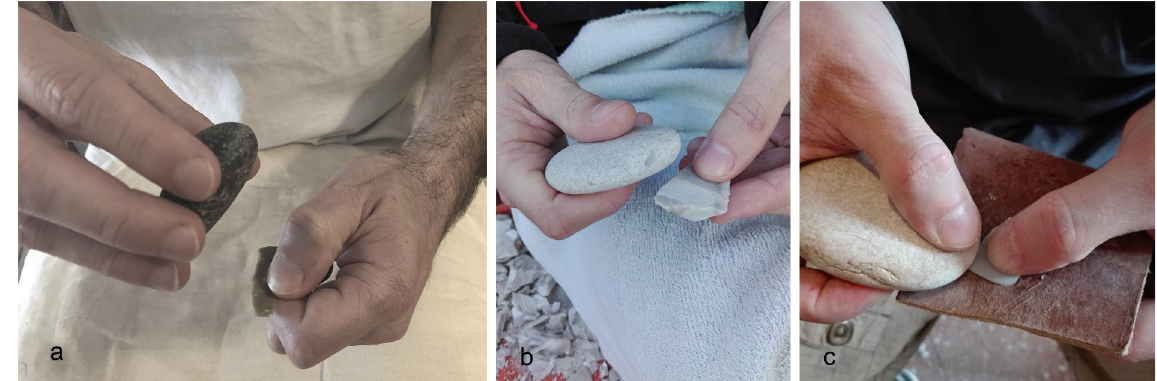
Fig 4. Experimental retouching. (a) Production of marginal and abrupt retouch; (b) production of scaled retouch on the lateral edge of a laminar flake; (c) blank retouch through edge abrasion.